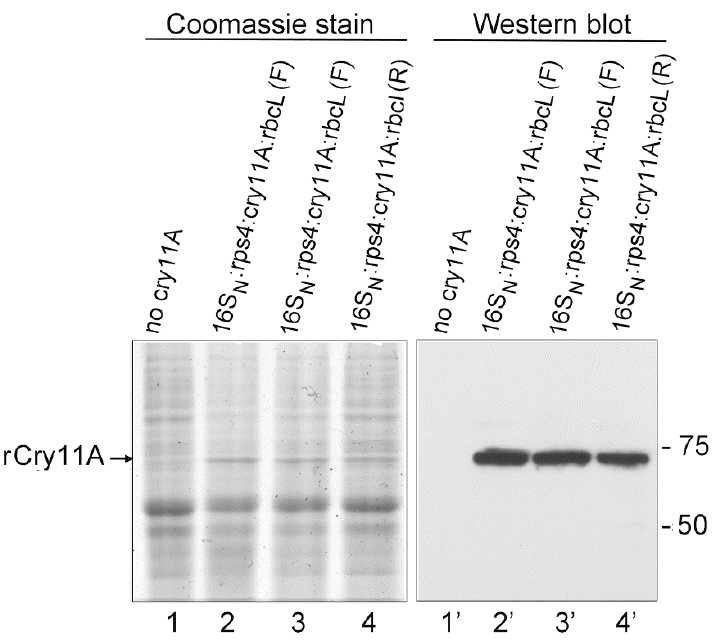
Figure 7. Stability of the 16S N :rps4:cry11A:rbcL strains, and visualization of rCry11A on Coomassie stained gels of total protein. The two 16S N :rps4:cry11A:rbcL (F) preparations (lanes 2–3) were made from the same transformant line 15 months apart. The total protein preparation from the 16S N :rps4:cry11A:rbcL (R) transformant was made after carrying it for ~18 months. Duplicate 8% polyacrylamide gels were co-electrophoresed; one was stained with Coomassie blue ( left panel, lanes 1 – 4) and the other was blotted and probed with the anti-Flag monoclonal antibody ( right panel, lanes 1 ′– 4 ′ ). The positions of two of the pre-stained size markers are indicated to the right of the blot, and the position of rCry11A on the left. The negative control lane (lanes 1 and 1 ′ ) was from a transformant that lacked the transgene.